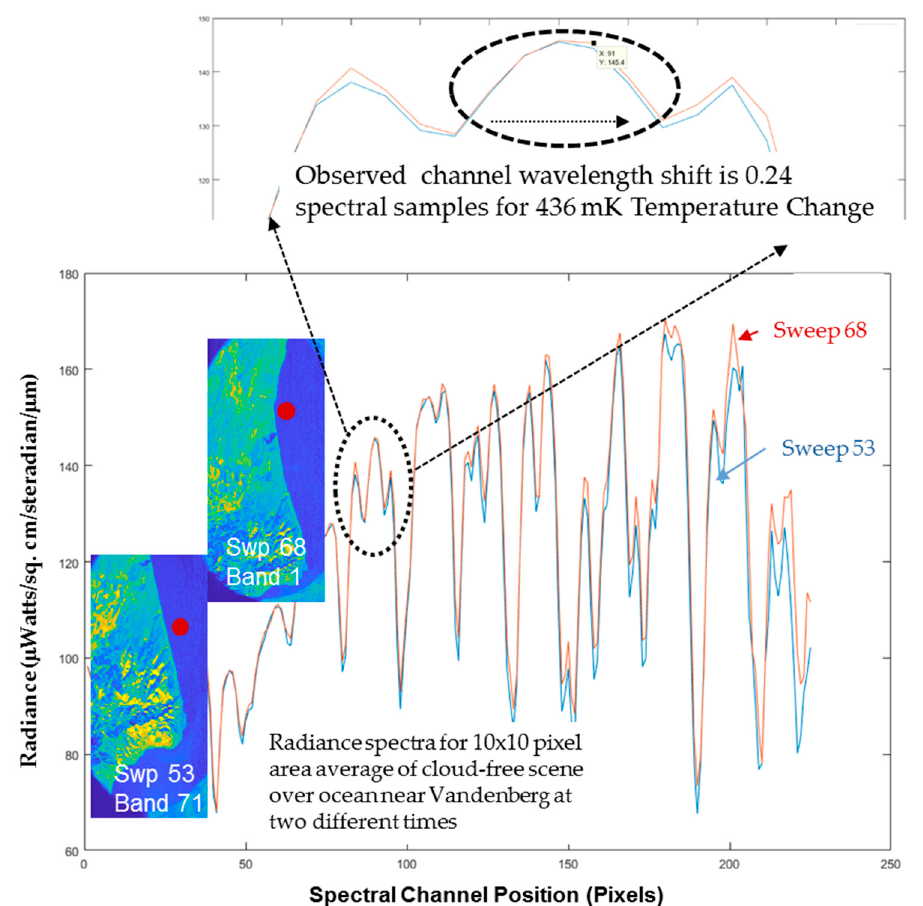
Figure A4. Airborne repeat-pass spectral imaging observations over the Pacific provided a test of the temperature sensitivity of the spectral calibration. The observed shift of < 0.05 spectral samples per 100 mK is 2 × better (less) than the required temperature sensitivity of spectral calibration needed to maintain spectral calibration stability on-orbit.